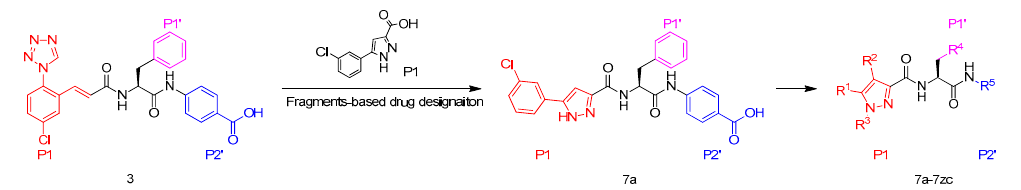
Figure 4. Design of FXIa inhibitors in present study.